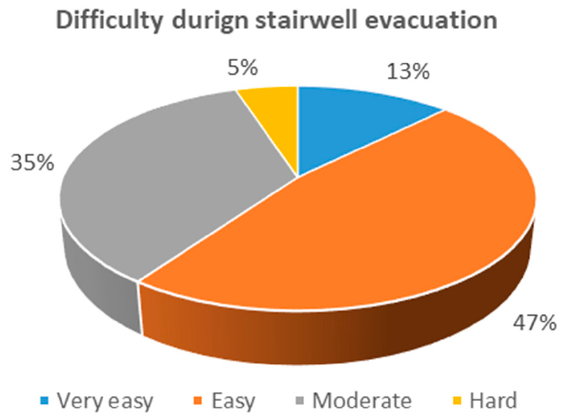
Figure 23. Difficulty during stairwell evacuation.